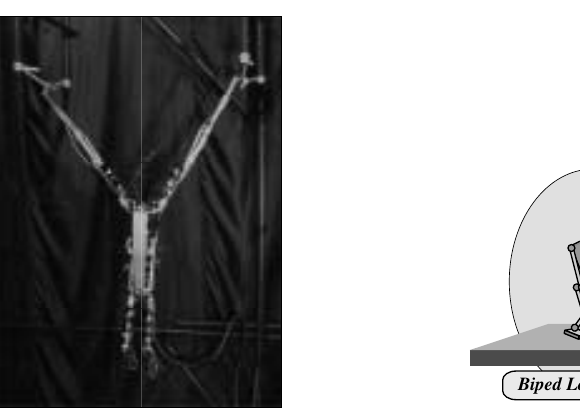
Figure 6 Concept of the multi-locomotion